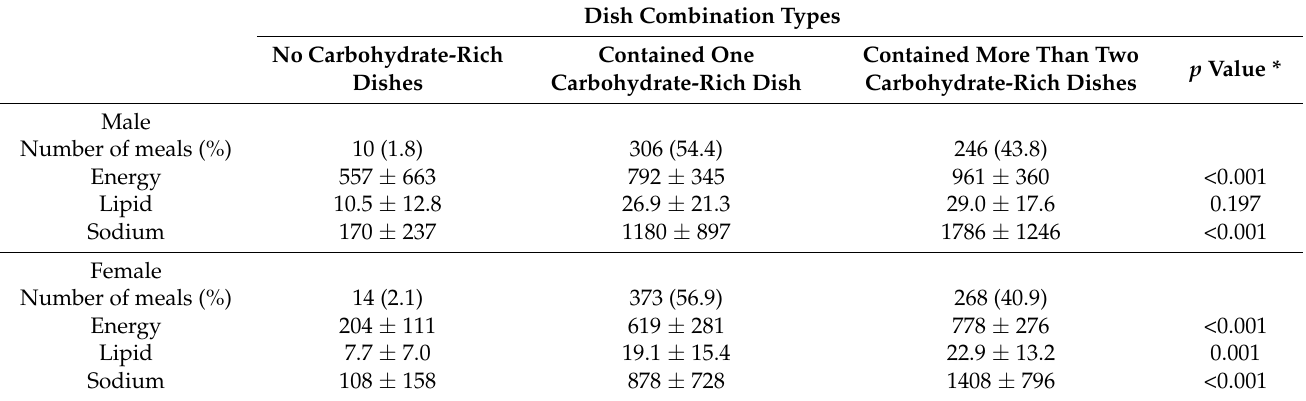
Table 7. Dish combination types and their mean energy, lipid, and sodium intake differences between meal types.